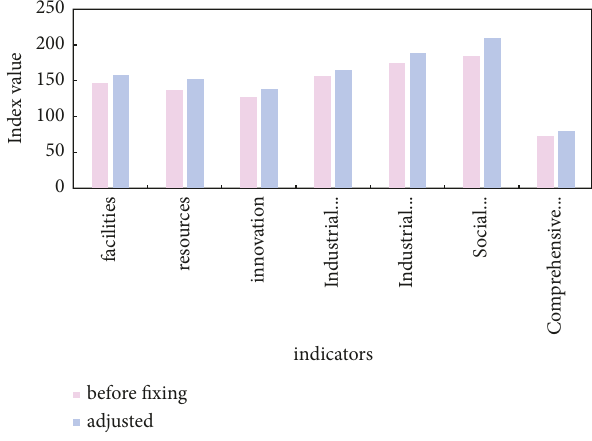
Figure 10: Digital economy development